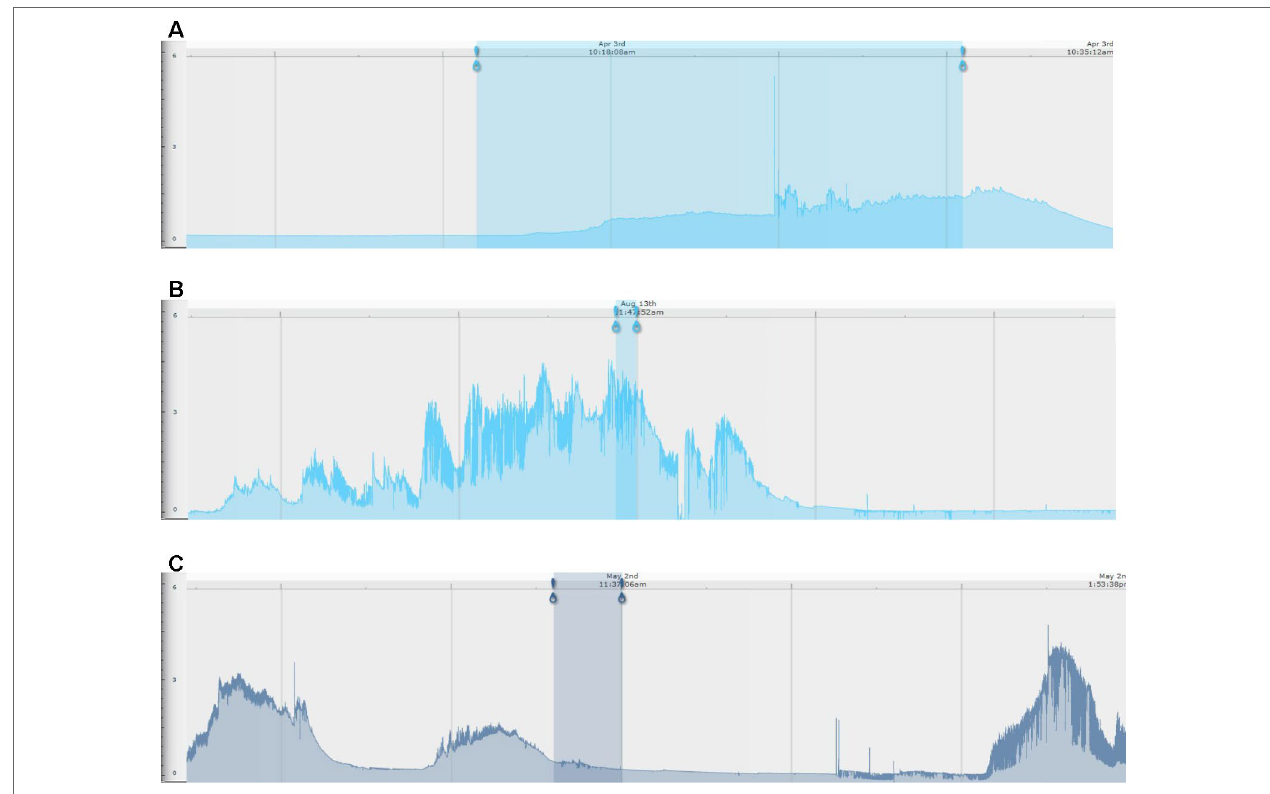
FIGURE 2 | Examples of skin conductance level traces by behavioral subtype. For all images, the blue-shaded area represents the time period of an individual engaging in problem behavior. The left-most blue pin represents the beginning of the problem behavior, and the right-most pin represents the end of the problem behavior. (A) No EDA build-up prior to engaging in problem behavior (in this example, jumping in seat); (B) EDA build-up prior to engaging in problem behavior (in this example, jumping in seat); (C) EDA build-up prior to engaging in problem behavior (in this example, repetitive body hitting) and subsequent reduction with engagement in problem behavior. The x-axis is EDA in microsiemens, and the y-axis is time (marked at the top of each EDA